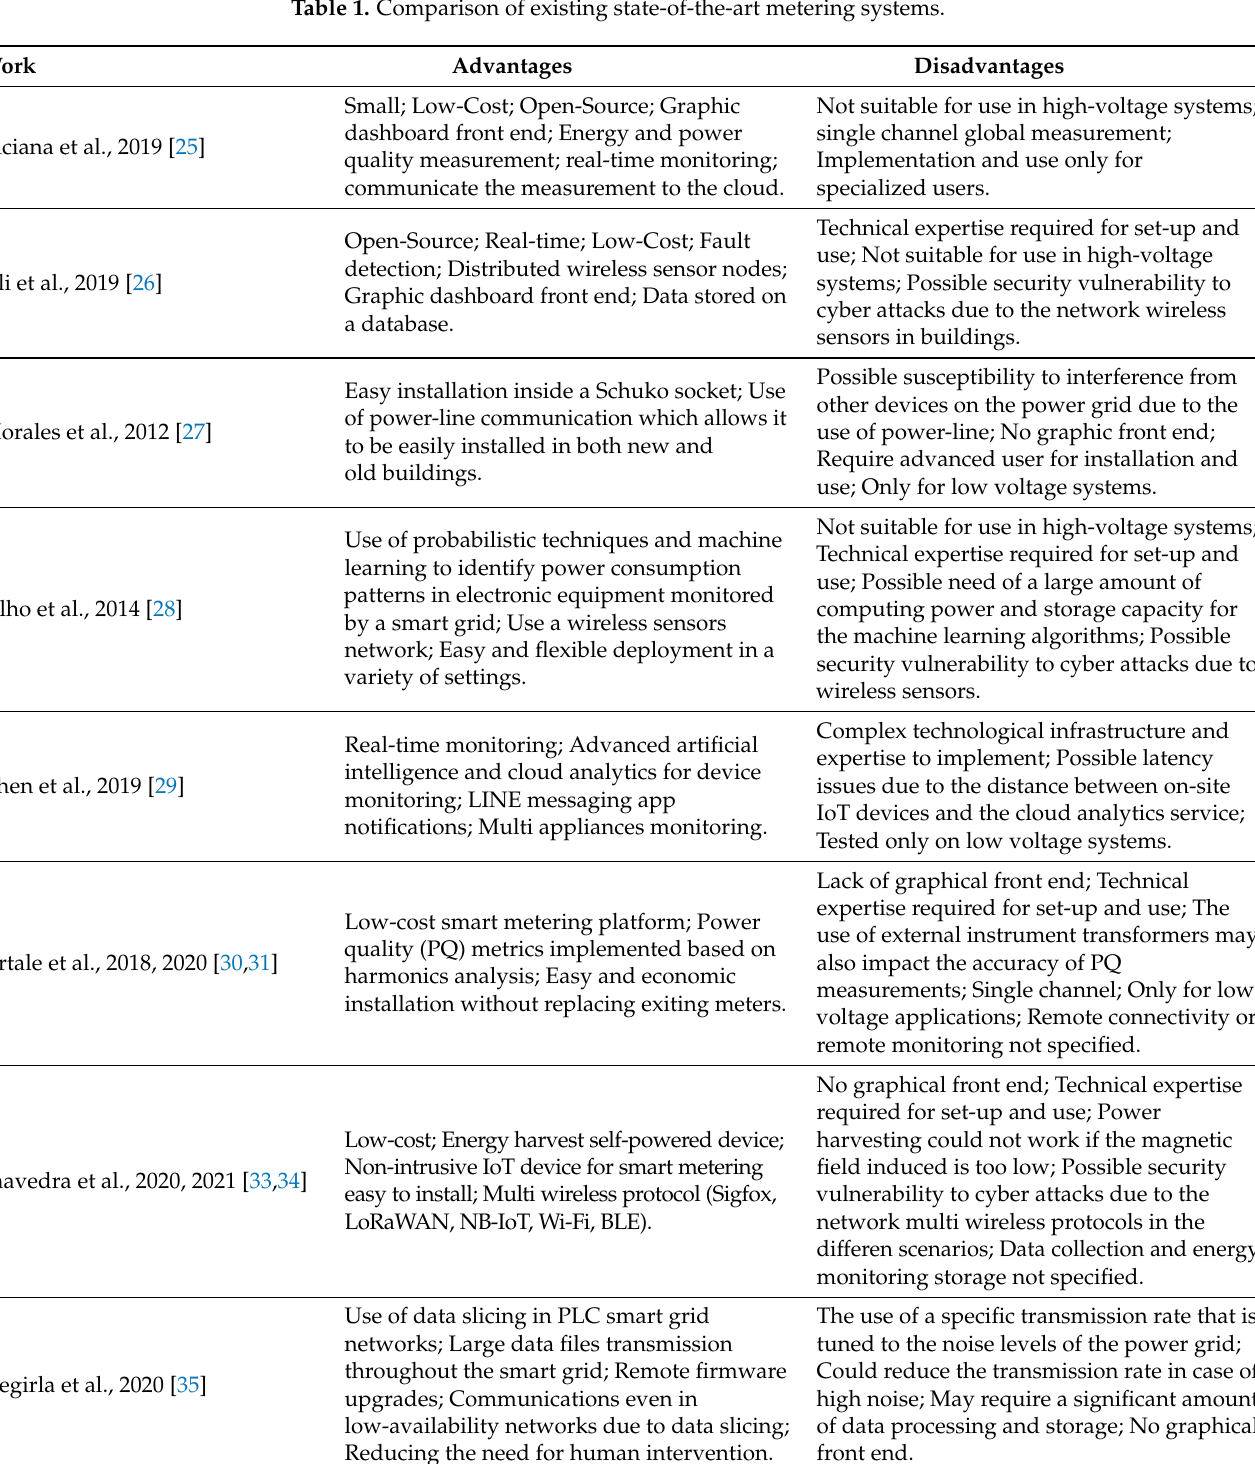
Table 1. Comparison of existing state-of-the-art metering